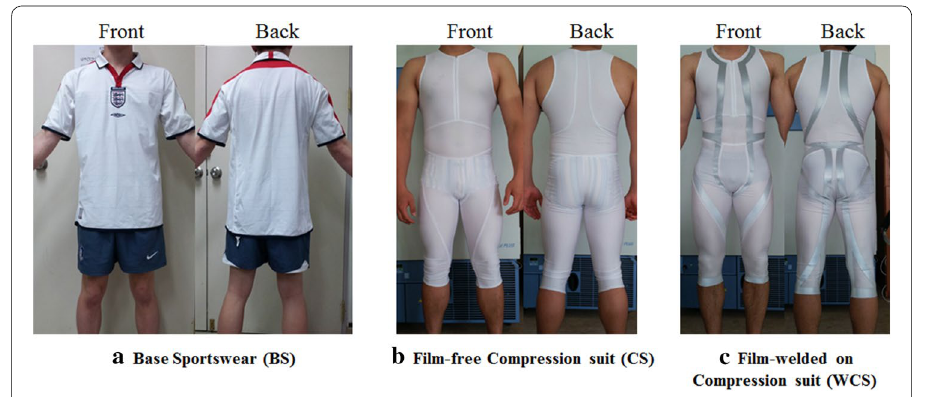
Fig. 1 Experimental garments used in this study